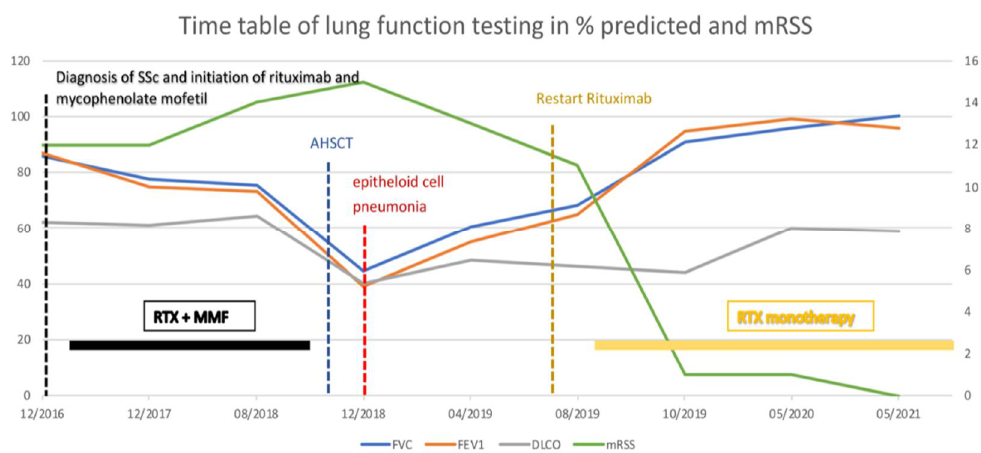
Figure 1. Clinical evolution of the disease showing lung function in % predicted and mRSS in relation to treatments. AHSCT = autologous hematopoietic stem cell transplantation, RTX = Rituximab, MMF = mycophenolate mofetil, mRSS = modified Rodnan Skin Score, FVC = forced vital capacity, FEV1 = forced expiratory volume during first second, DLCO = diffusing capacity for carbon monoxide.